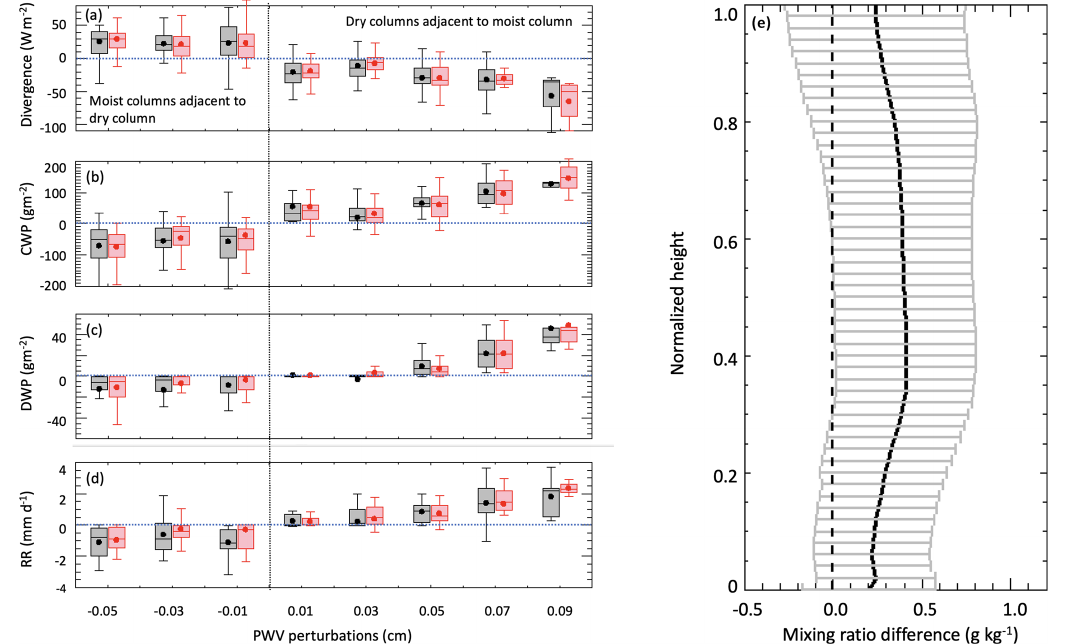
Figure 9. (a–d) Differences in cloud-top radiative cooling, cloud water path, drizzle water path, and rain rate at cloud base between each identified region ( x axis) and the two adjacent regions binned by the strength of the region’s PWV perturbation: N = 25, 22, 19, 15, 20, 15, 13, and 5. Differences are computed as center-minus-preceding (black) and center-minus-following (red) columns. (e) Vertical distribution of the mixing ratio differences between moist and dry columns. The height is normalized to the cloud-base height.